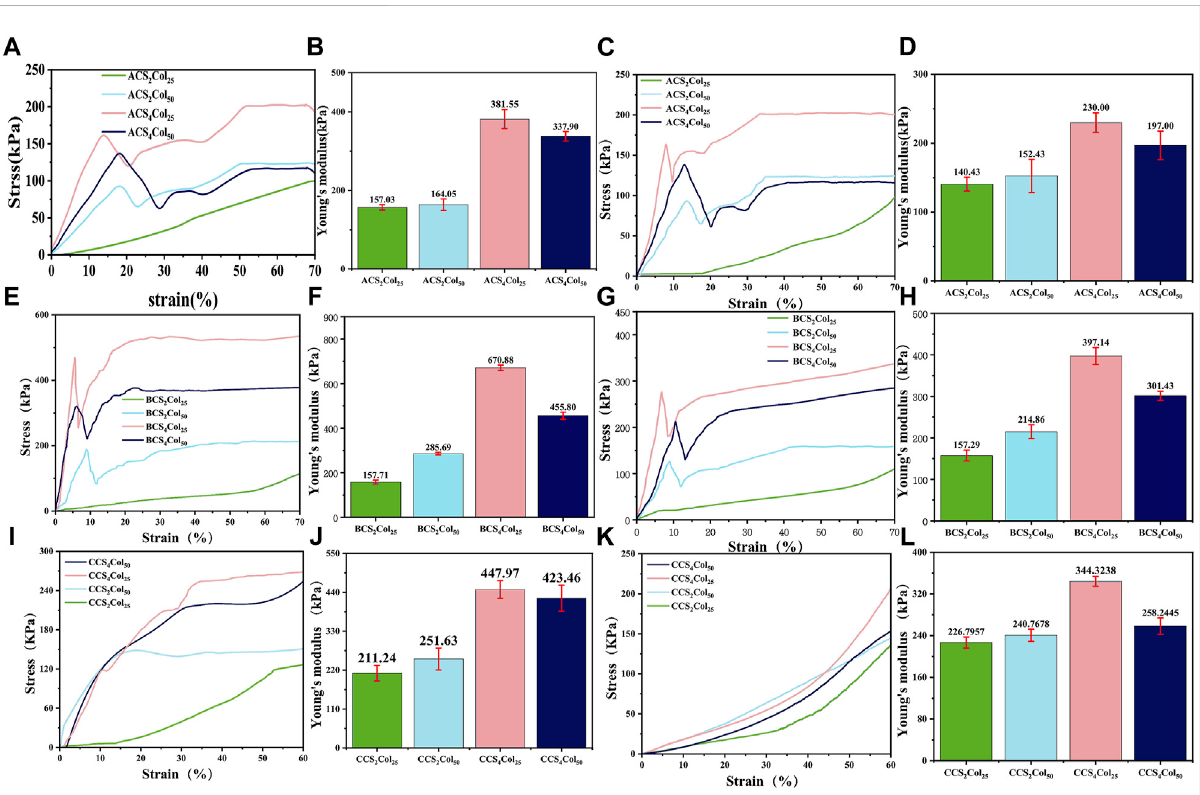
FIGURE 3 StressandstraincurvesandYoung ’ smodulusoftheCSColscaffolds.Longitudinal stressandstraincurvesandYoung ’ smodulusoftheACSCols (A,B) , BCSCols (E,F), and CCSCols (I,J) . Transverse stress and strain curves and Young ’ s modulus of the ACSCols (C,D) , BCSCols (G,H) , and CCSCols (K,L) (changed the fi gure ’ s color of